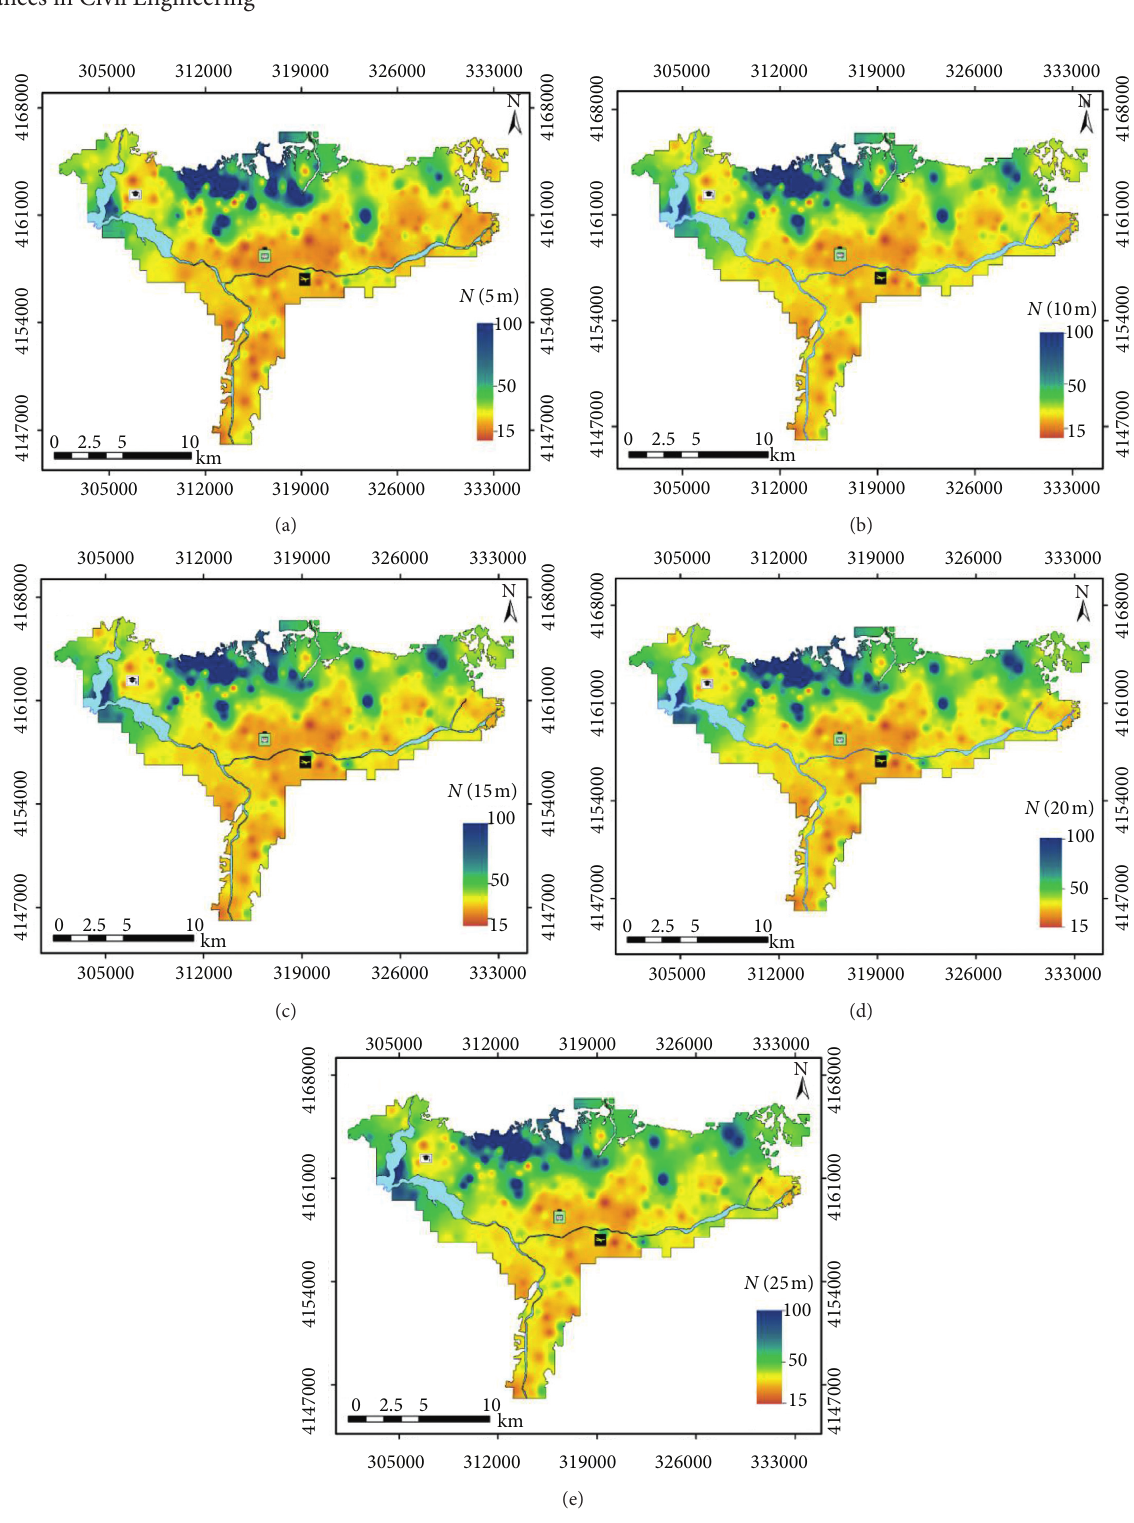
Figure 9: Average SPT-N values for the depths of (a) 5m, (b) 10m, (c) 15m, (d) 20m, and (e) 25m in Kahramanmaras